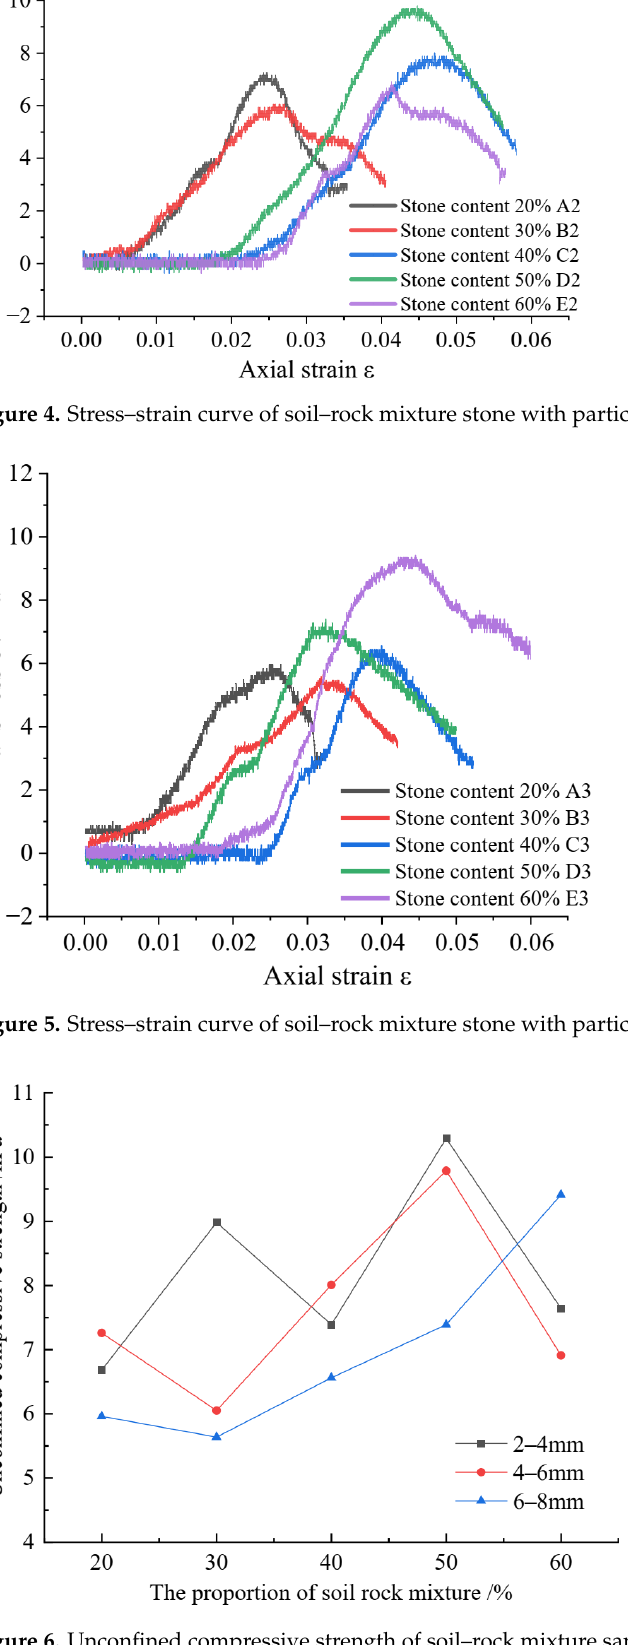
Figure 6. Unconfined compressive strength of soil–rock mixture samples with different rock